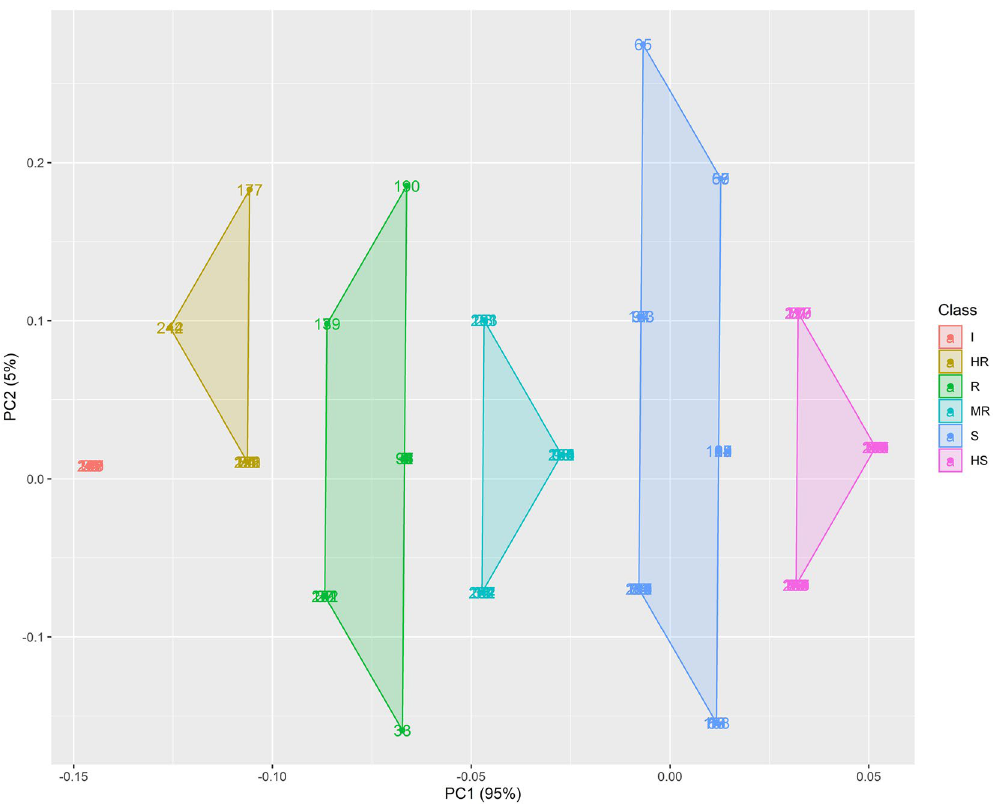
Figure 3. Principal coordinate analysis of the 258 banana genotypes based on the internal vascular discolouration score and disease